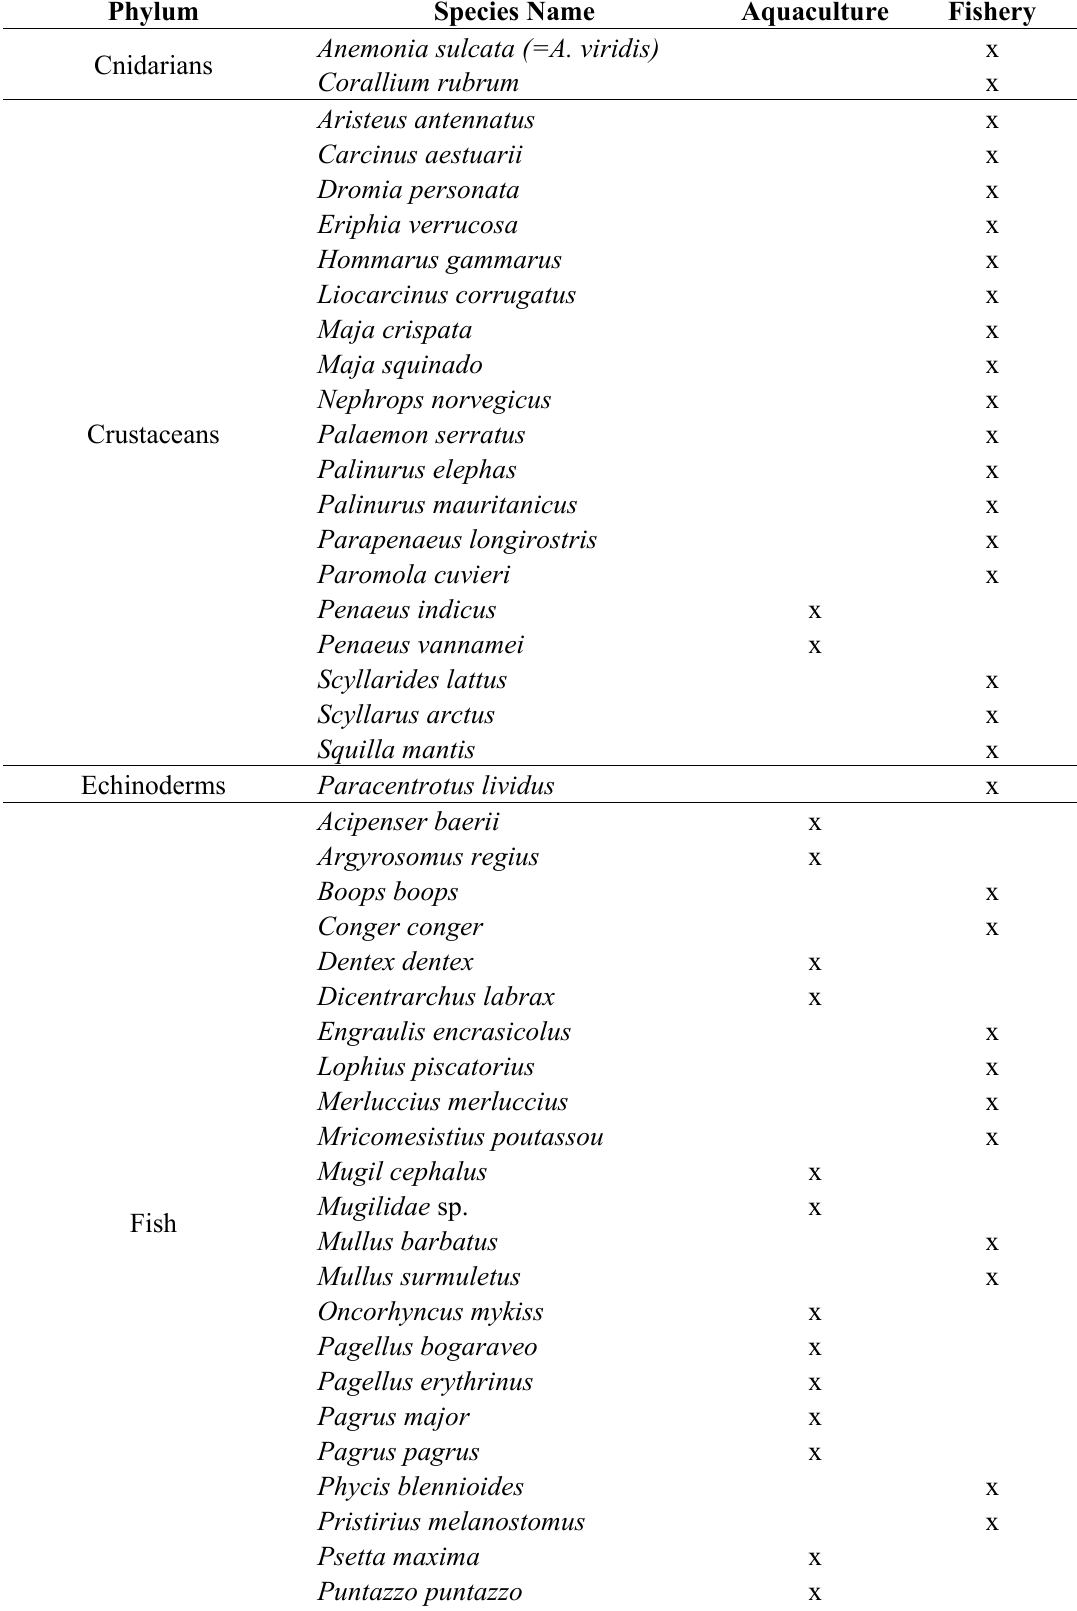
Table A1. List of animal species used in aquaculture or in fisheries in the Mediterranean.